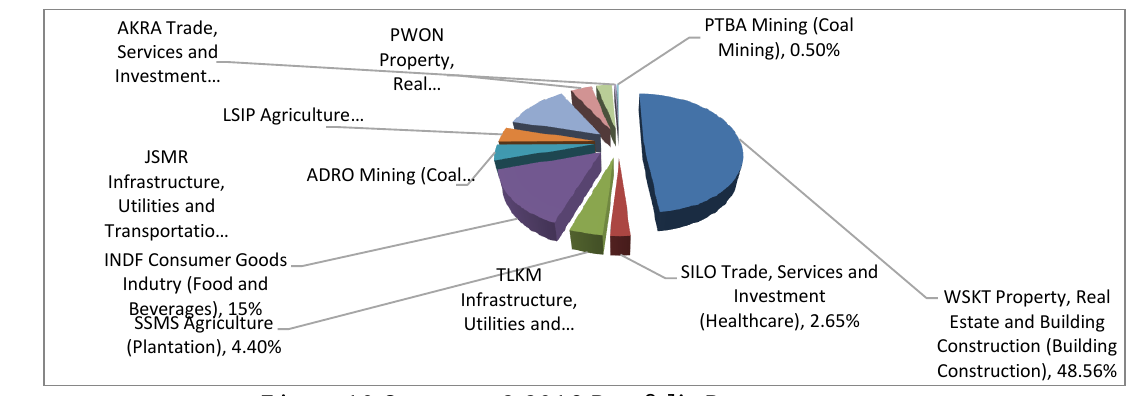
Figure 10 Semester 2 2016 Portfolio